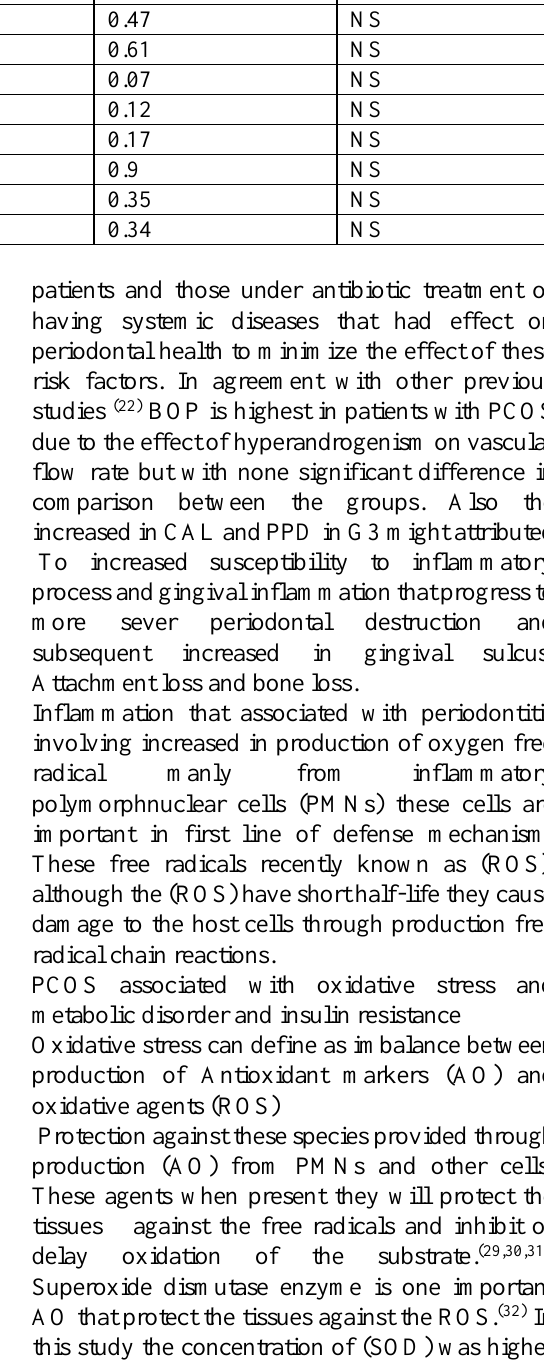
Table 4: Intergroup comparison of the SOD level (U/mL) with significant differences using T- Groups